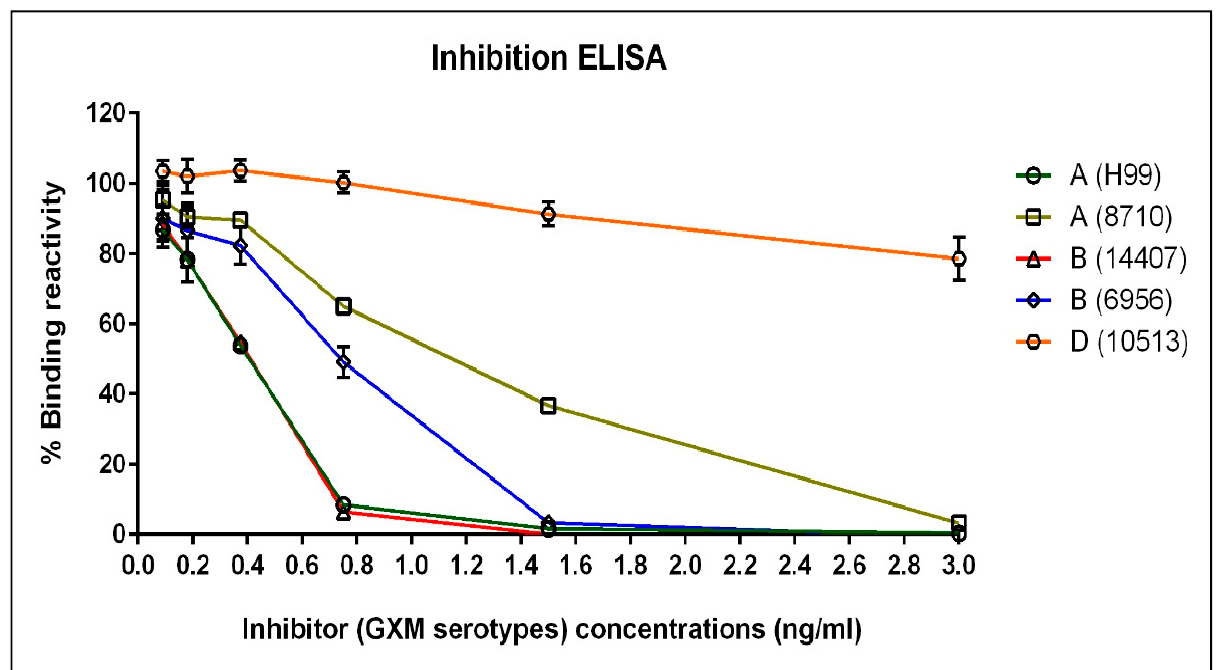
Figure 5. The immunoreactivity of mAb 18B7 with GXM derived from different serotypes of Cryptococcus sp . was investigated by an inhibition ELISA . The absorbance measurements were observed at OD 450 nm and were used to calculate the percentages of binding reactivities . The mAb 18B7 at 20 ng /mL was used in the inhibition ELISA . The error bar represented as mean OD ± SD of triplicated determination . The graph revealed the reactivities of GXM serotypes from high to low reactivity as follow; serotype A ( H99 ) = B ( 14407 ) > B ( 6956 ) > A ( 8710 ) > D ( 10513 ) , respectively . The A, B and D indicated the cryptococcal serotype and the name of each strain were indicated in the parenthesis .